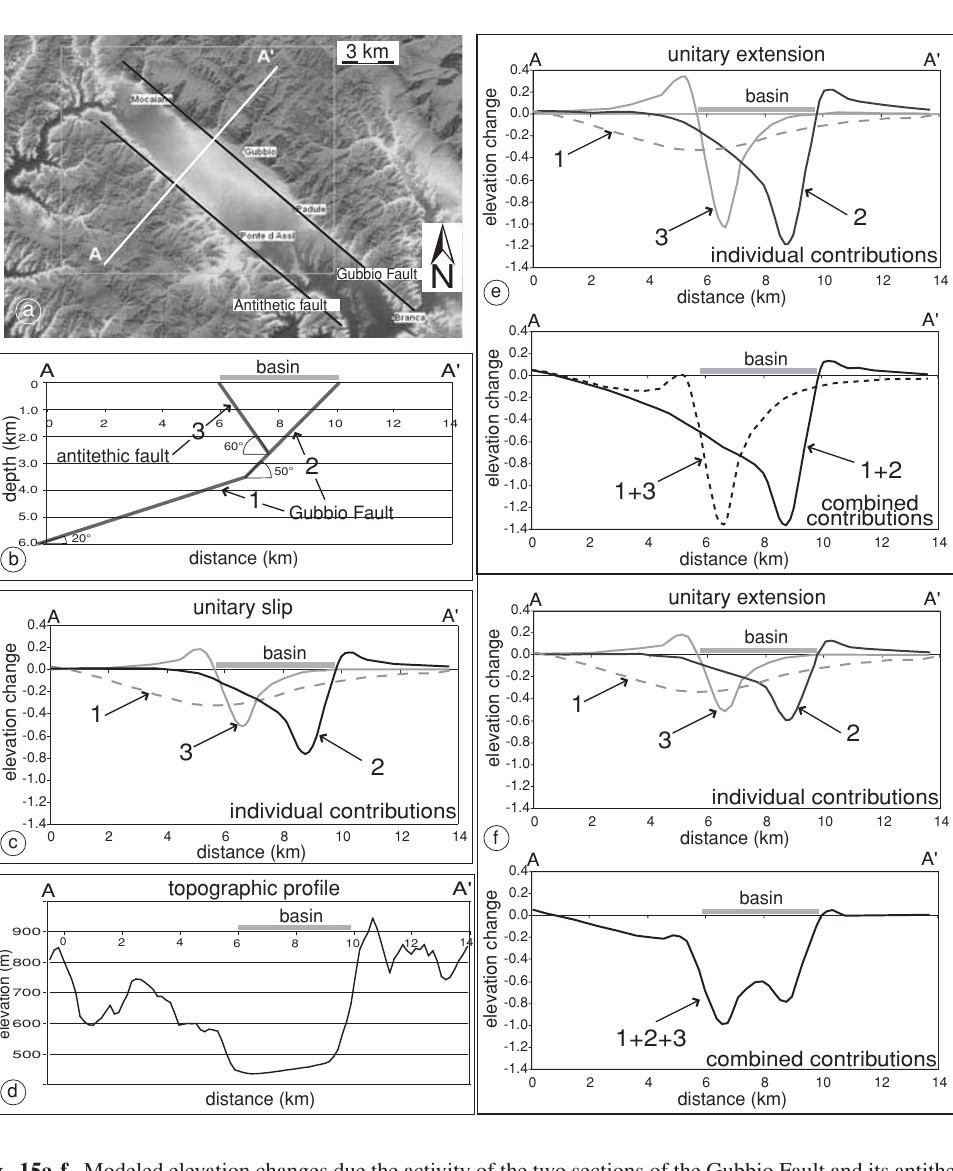
Fig. 15a-f. Modeled elevation changes due the activity of the two sections of the Gubbio Fault and its antithetic structure. a) Location map of the modeled transect. b) Sketch of the faults geometry adopted. c) Individual con- tributions of the faults, assuming a unitary slip for each of them. d) Topographic profile along the modeled tran- sect. e) Individual and combined contributions of the fault sections. Applying a unitary horizontal extension, NE- SW oriented, and assuming faults 2 and 3 accommodate alternatively the extension. Combination of faults 1 and 2 or faults 1 and 3 is shown in the lower part. f) Individual and combined contributions of the fault sections applying a unitary horizontal extension, NE-SW oriented, assuming the three faults work simultaneously. Each fault 2 and 3 has to accommodate half of the unitary extension. The combination of the three sections seems to fit well the topographic setting of the